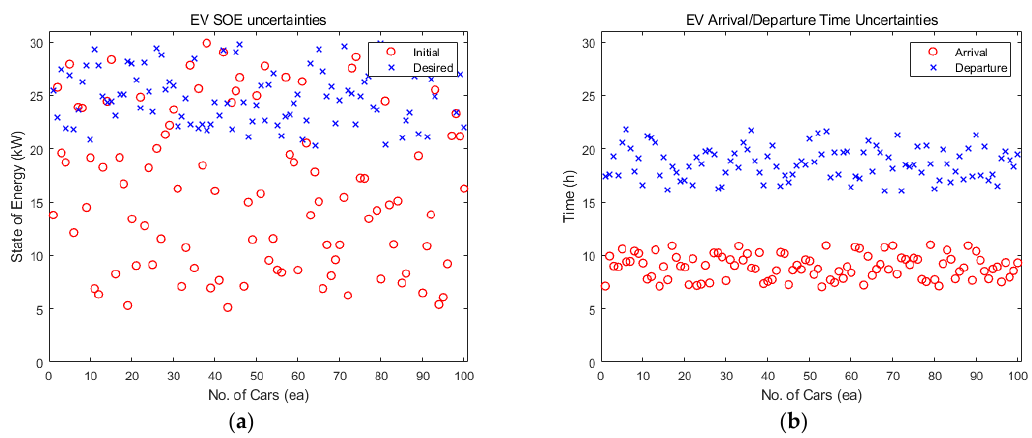
Figure 2. Randomly generated electric vehicle (EV pattern data: ( a ) Initial/desired state of energy (SOE); ( b ) arrival/departure time.